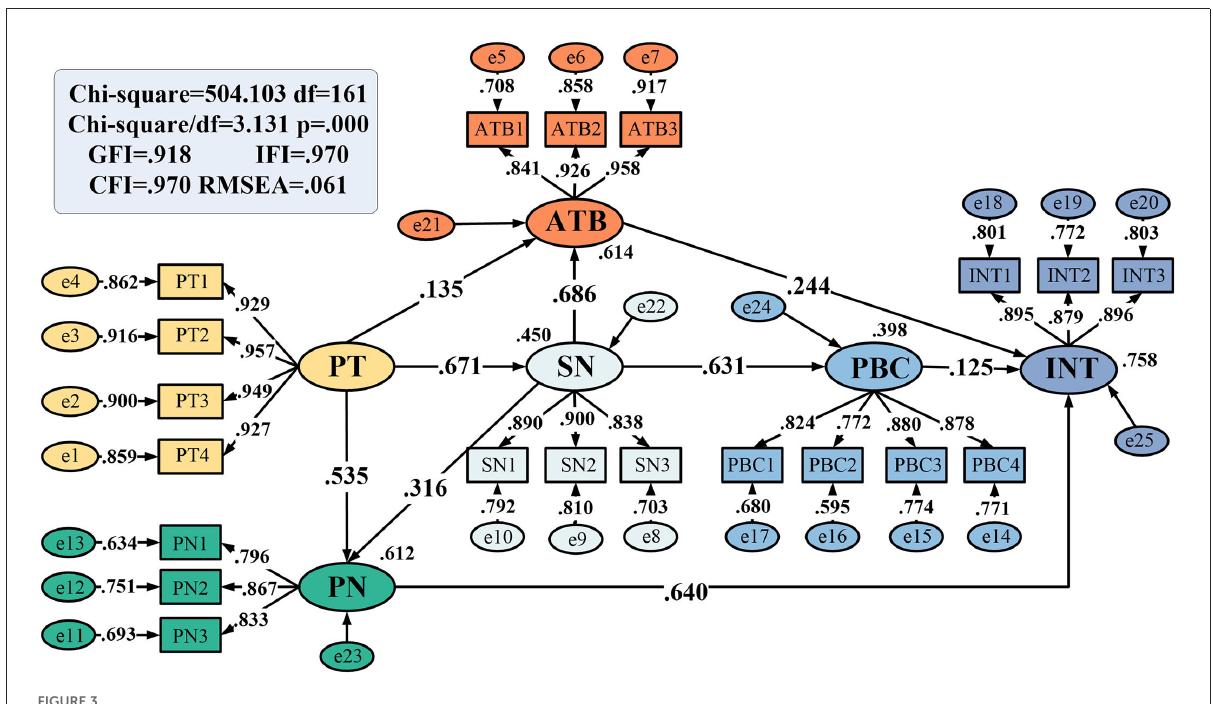
FIGURE3 Path diagram of the integrated TPB-NAM model.